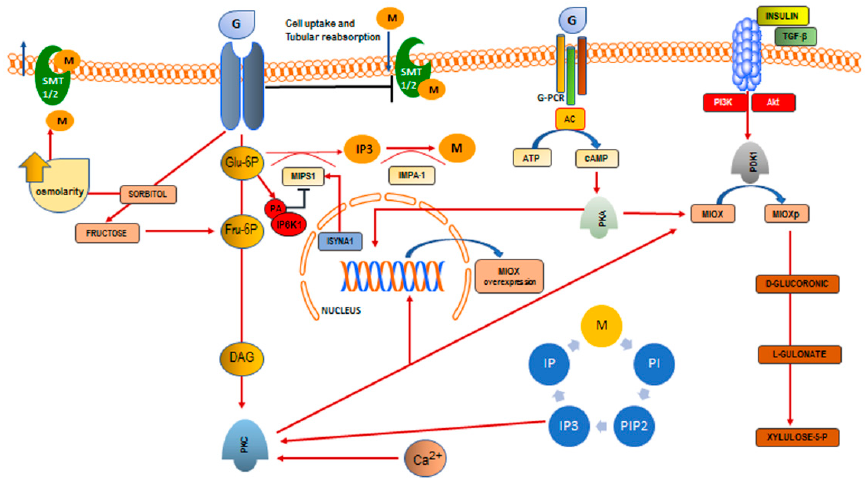
Figure 1. Glucose-inositol relationships. High glucose levels inhibit myo-Ins uptake by cells, by competing with SMT1/2 transporter systems. Moreover, through the activation of the polyol pathway, glucose extrudes myo-Ins from cells, thus “buffering” the increased osmolarity due to the augmented sorbitol levels. Biosynthesis of myo-Ins begins with G-6P enzymatic transformation into inositol-1-phosphate. However, high glucose levels indirectly inhibit myo-Ins biosynthesis, by increasing intracellular PA and consequently activating IP6K1, the principal negative regulator of myo-Ins de novo synthesis. Ultimately, glucose increases renal tubular catabolism and urinary loss of inositol through MIOX activation and overexpression. DAG, diacylglycerol; PKC, PKA, protein kinase C and